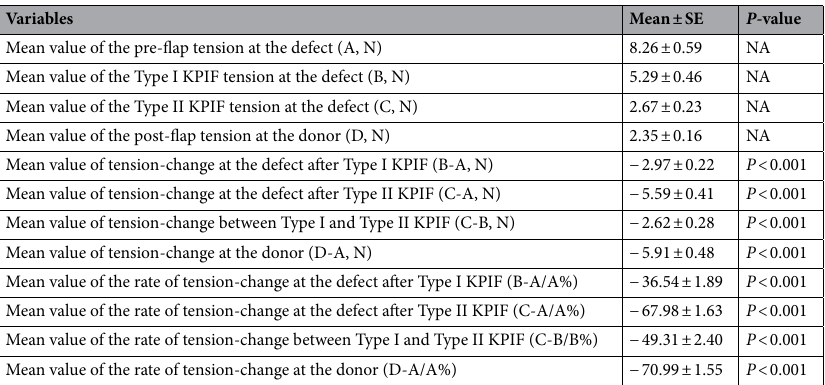
Table 3. Summary of tensiometer data. All variables, difference between paired variables, and rate of change are expressed as mean ± SE; P values were obtained using Wilcoxon signed-rank test. N Newton, KPIF keystone perforator island flap, SE standard